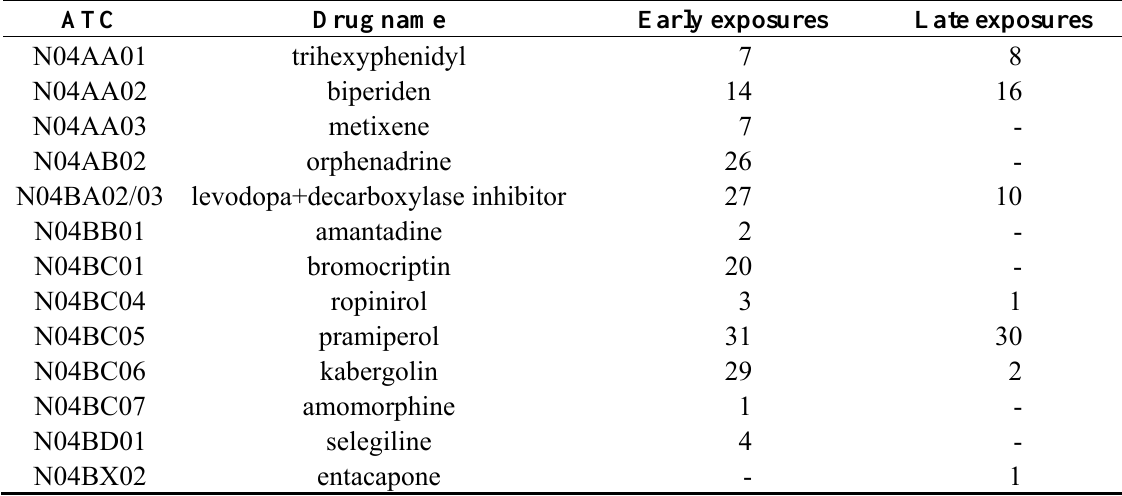
Table 16. Number of infants exposed in early pregnancy for drugs used for Parkinson’s disease.